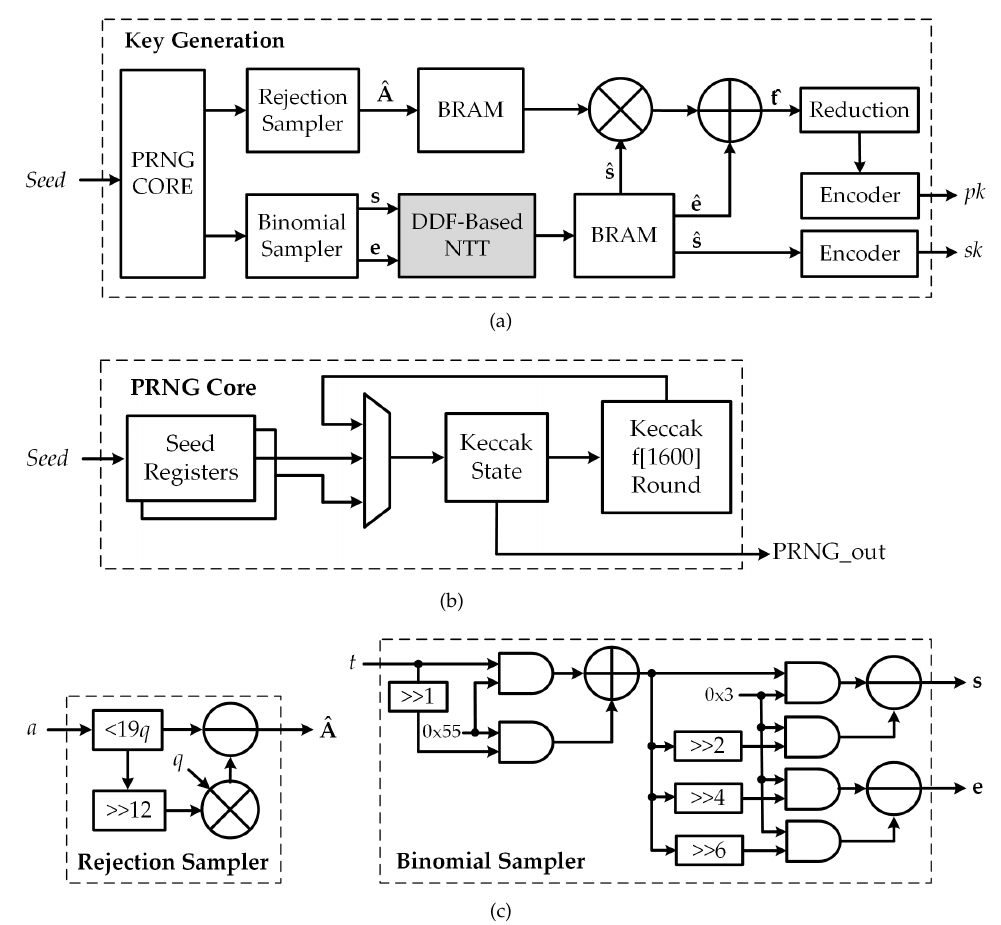
Figure 3. Proposed DDF NTT-based key generation architecture. ( a ) Top level of key generation architecture, ( b ) PRNG core architecture, and ( c ) rejection and binomial